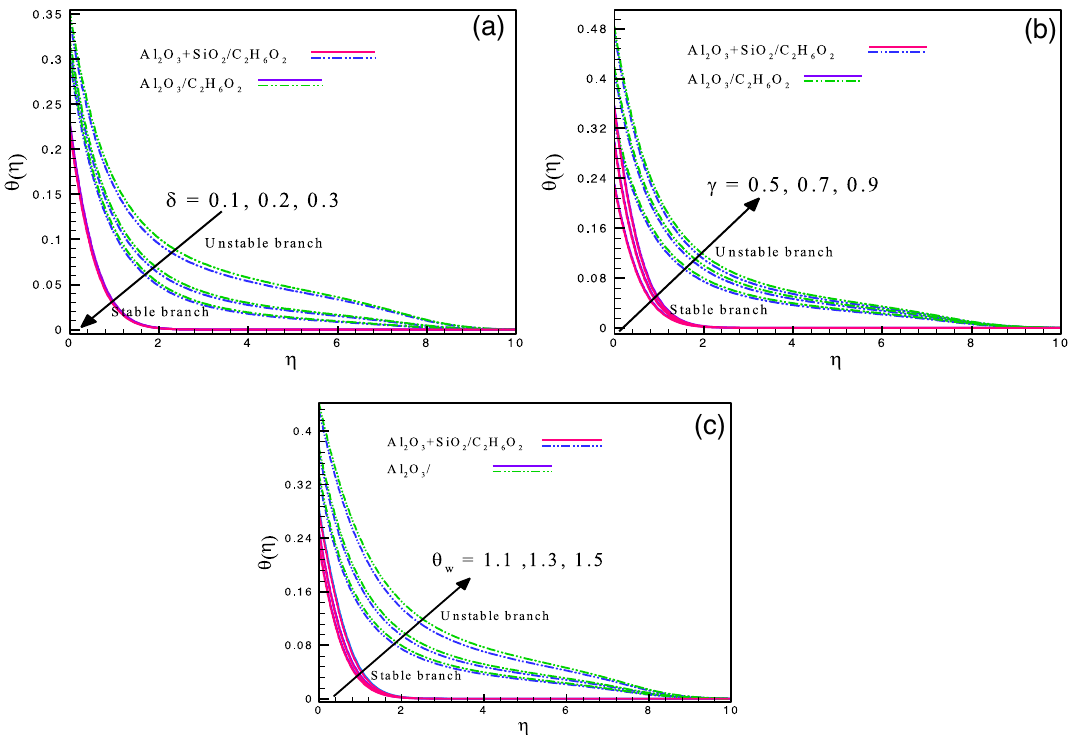
Figs. 6. ( a )–( c ): Variation of θ(η) for different values of δ , γ , and θ w .